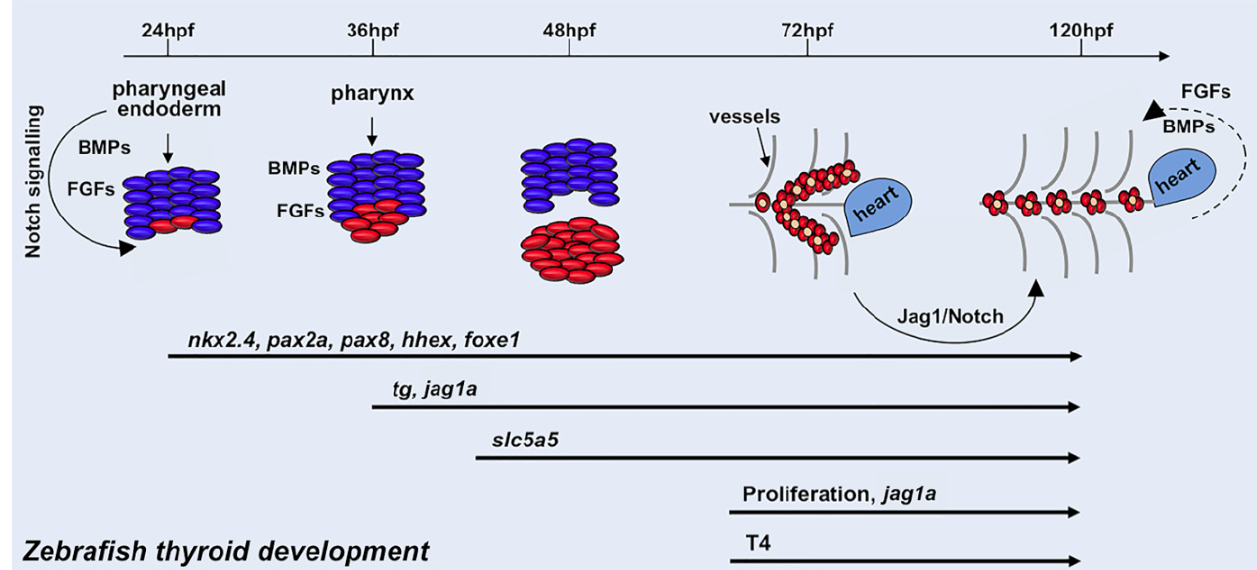
Figure 2. Schematic illustration of zebrafish thyroid development (modified from 7). The thyroid primordium rises from the pharyngeal endoderm around 24 hours post-fertilization (hpf) and expresses the early thyroid genes nkx2.4, pax2a, pax8, hhex, and foxe1 . The differentiation of thyroid precursors continues up to 48hpf, at which they begin to express the late thyroid genes tg and slc5a5 . The development of the zebrafish thyroid gland is complete at 72hpf. From this time, the thyroid follicles proliferate and localize along the dorsal aorta and start to produce T4. Intrinsic and extrinsic factors (Jag1-Notch, bone morphogenetic protein [BMP], and fibroblast growth factor [FGF] signaling) are also reported to play a pivotal role during thyroid organogenesis. For a detailed description of the molecular mechanisms underlying zebrafish thyroid morphogenesis, we refer the reader to the review by Fagman and Nilsson 11